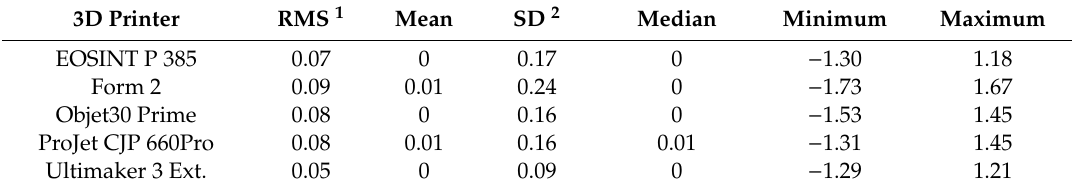
Table 6. Summary of all precision analyses values (mm) for each 3D printer.